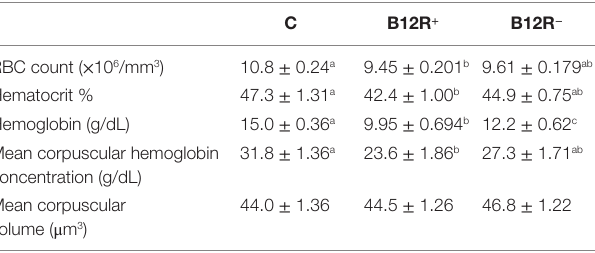
TaBle 4 | hematological parameters after 4 weeks of feeding (before breeding).